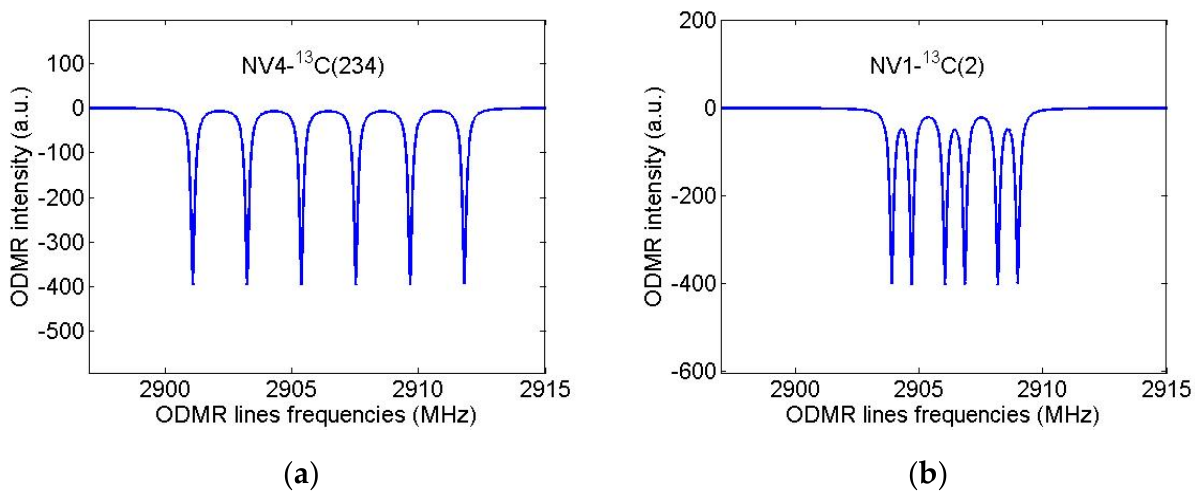
Figure 8. Simulated high-resolution ODMR spectra forthe NV4- 13 C(234) ( Δ 0 ~ 6429 kHz) ( a ) and NV1- 13 C(2) ( Δ 0 ~ 804 kHz) ( b ) spin systems in nanodiamonds grown from 2-azaadamantane. Magnetic field B = 13 G was assumed to be aligned along NV axis, ODMR linewidths were taken to be 0.1 MHz.